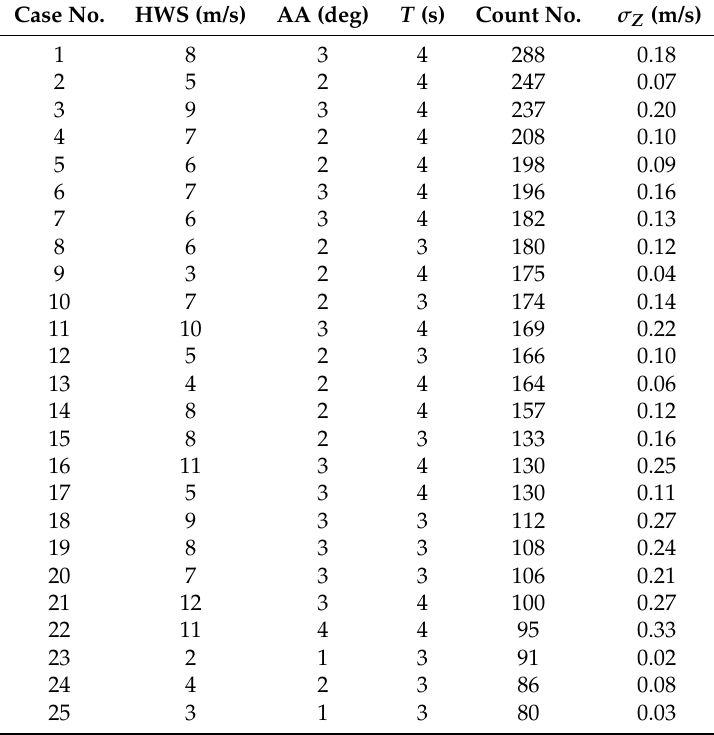
Table 1. The 25 most frequent HWS and motional cases in the IJmuiden campaign. “Case no.” is the bin number sorted by decreasing frequency of event occurrence (“1” indicating the most frequent case); HWS (m/s) stands for 10-min mean horizontal wind speed; AA (deg) stands for motion angular amplitude; T (s) stands for period; Count no. is the bin count number; and σ Z (m/s) is the motion-induced HWS error standard deviation estimated by the simulator after Equation (4). Case No. HWS (m/s) AA (deg) T (s) Count